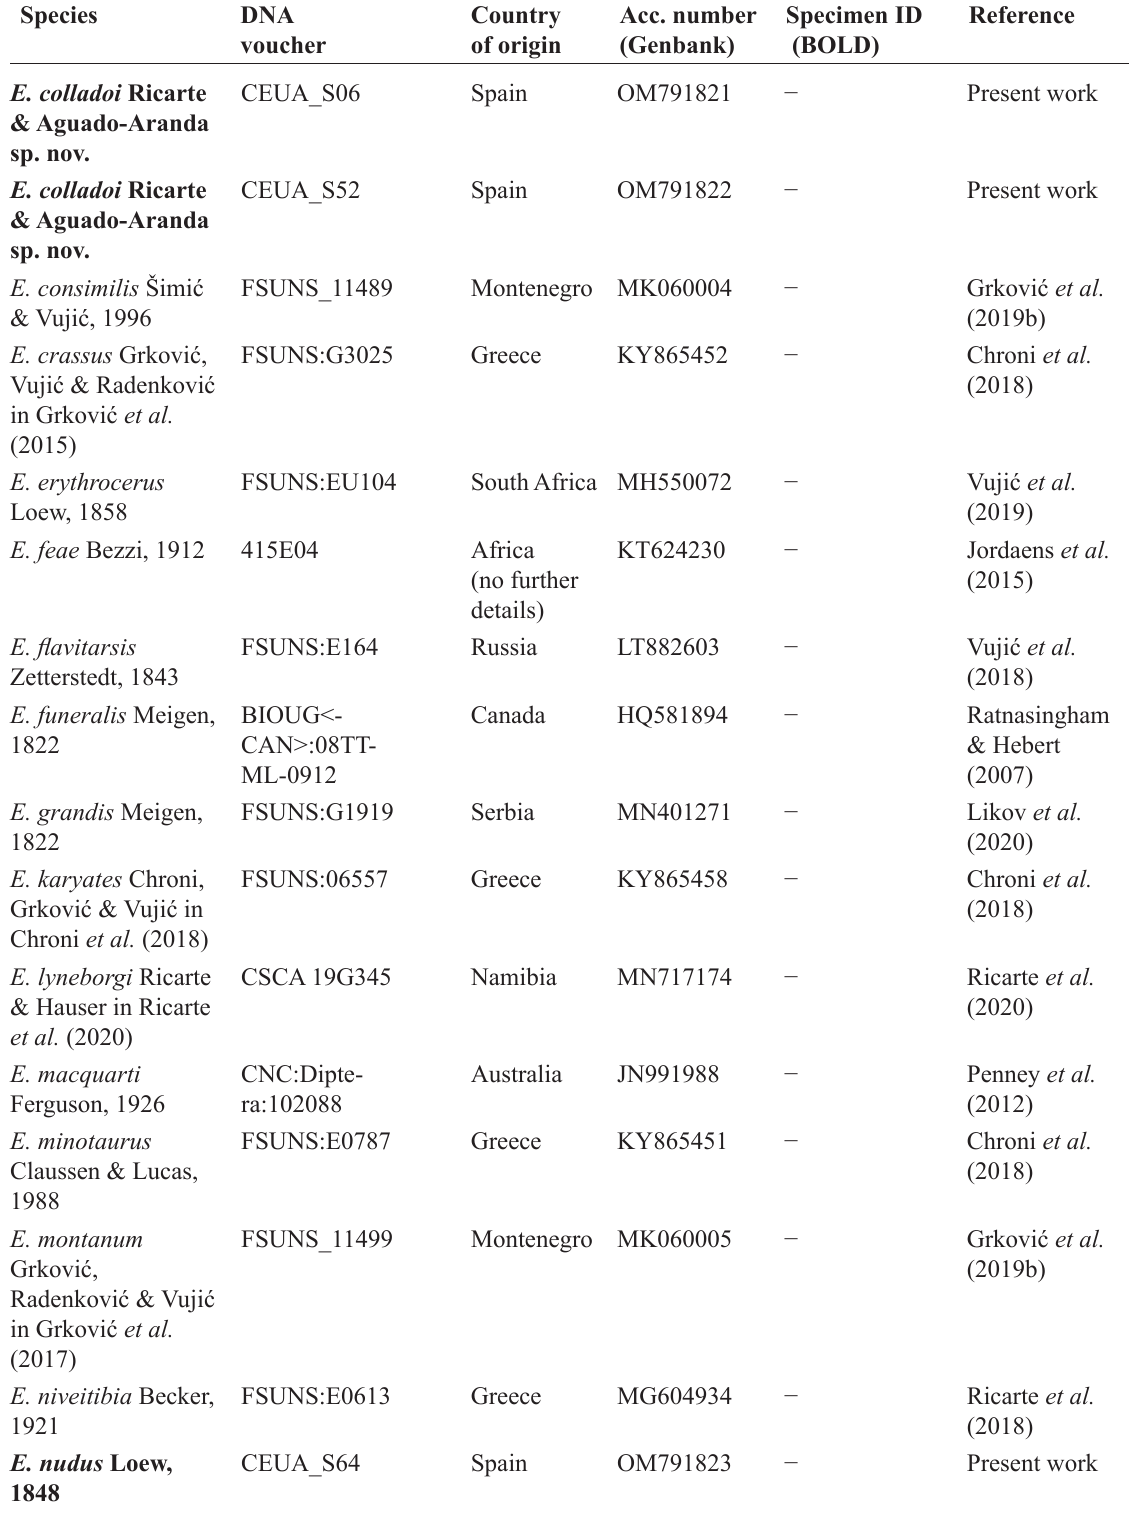
Table 1 (continued). List of the species used in the molecular analyses. New sequences generated for this work are highlighted in